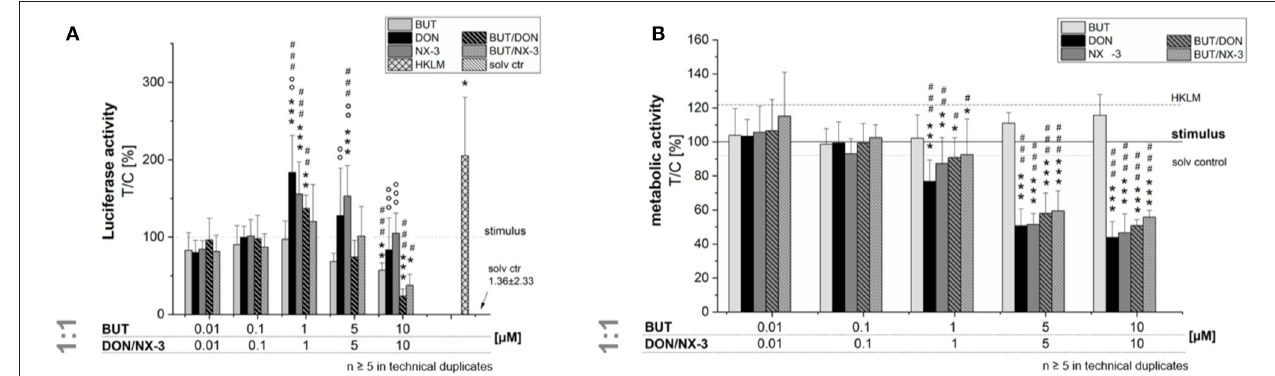
FIGURE 2 | Effect of toxin treatment on NF- κ B-dependent luciferase (ratio LPS treated/untreated control). Modulation of NF- κ B-dependent luciferase expression (A) after 2h pre-incubation with BUT (0.01–10 µ M), DON (0.01 µ M-10 µ M), NX-3 (0.01 µ M-10 µ M) and respective equimolar combinations, followed by 18h co-stimulation with LPS (10ng/mL) in THP1-Lucia TM cells referred to the respective alamarBlue ® -fluorescence intensity (B) . 2% (v/v) water (LC-MS grade) with (dotted line) and without LPS treatment (solv ctr) served as solvent control, HKLM (20 × 10 6 cells/well) as positive control. alamarBlue ® -fluorescence intensity and luciferase activity data are expressed as mean values ± SE of at least five independent experiments performed in duplicates normalized to the LPS-stimulated solvent control [2% water (LC–MS grade)]. Significant differences to the stimulated solvent control are indicated with * p < 0.05, ** p < 0.01, and *** p < 0.001, significant differences between concentrations of the same compound with the respective lowest tested concentration, calculated by one-way ANOVA, followed by Bonferroni’s post-hoc tests, are indicated with # p < 0.05, ## p < 0.01, and ### p < 0.001, whereas significant differences of the compound mixtures to the respective data of DON and NX-3 as single compounds are indicated with ◦ p < 0.05, ◦◦ p < 0.01, and ◦◦◦ p < 0.001.